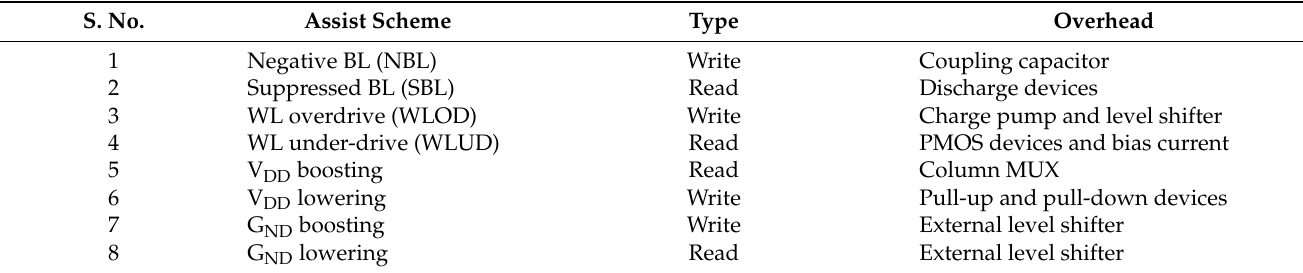
Table 3. Summary of assist scheme for read and write at the low * Area estimation using 65 nm design rules.